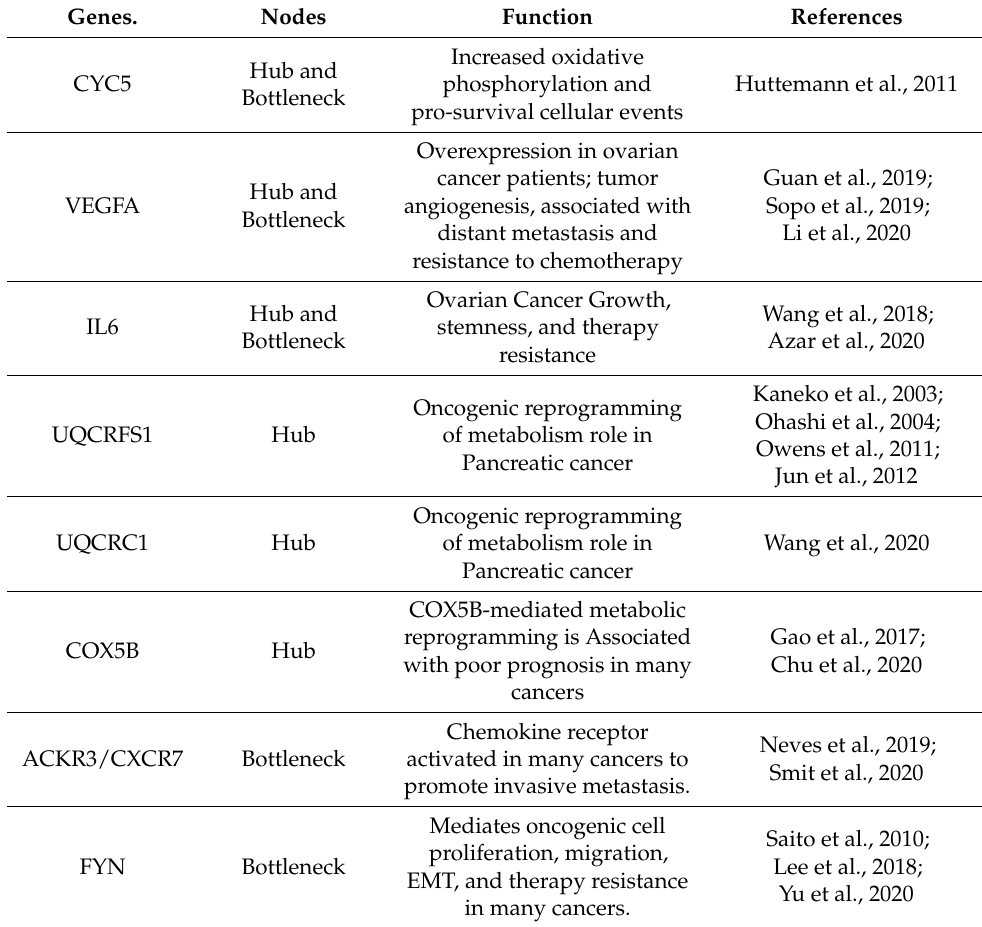
Table 3. Hub and bottleneck genes of the PPI network. The top five genes derived from the PPI network using MCC, MNC, Degree, EPC, and EcCentricity algorithms of the CytoHubba plugins in Cytoscape and top five bottleneck genes determined from the BottleNeck algorithm are presented. Genes. Nodes